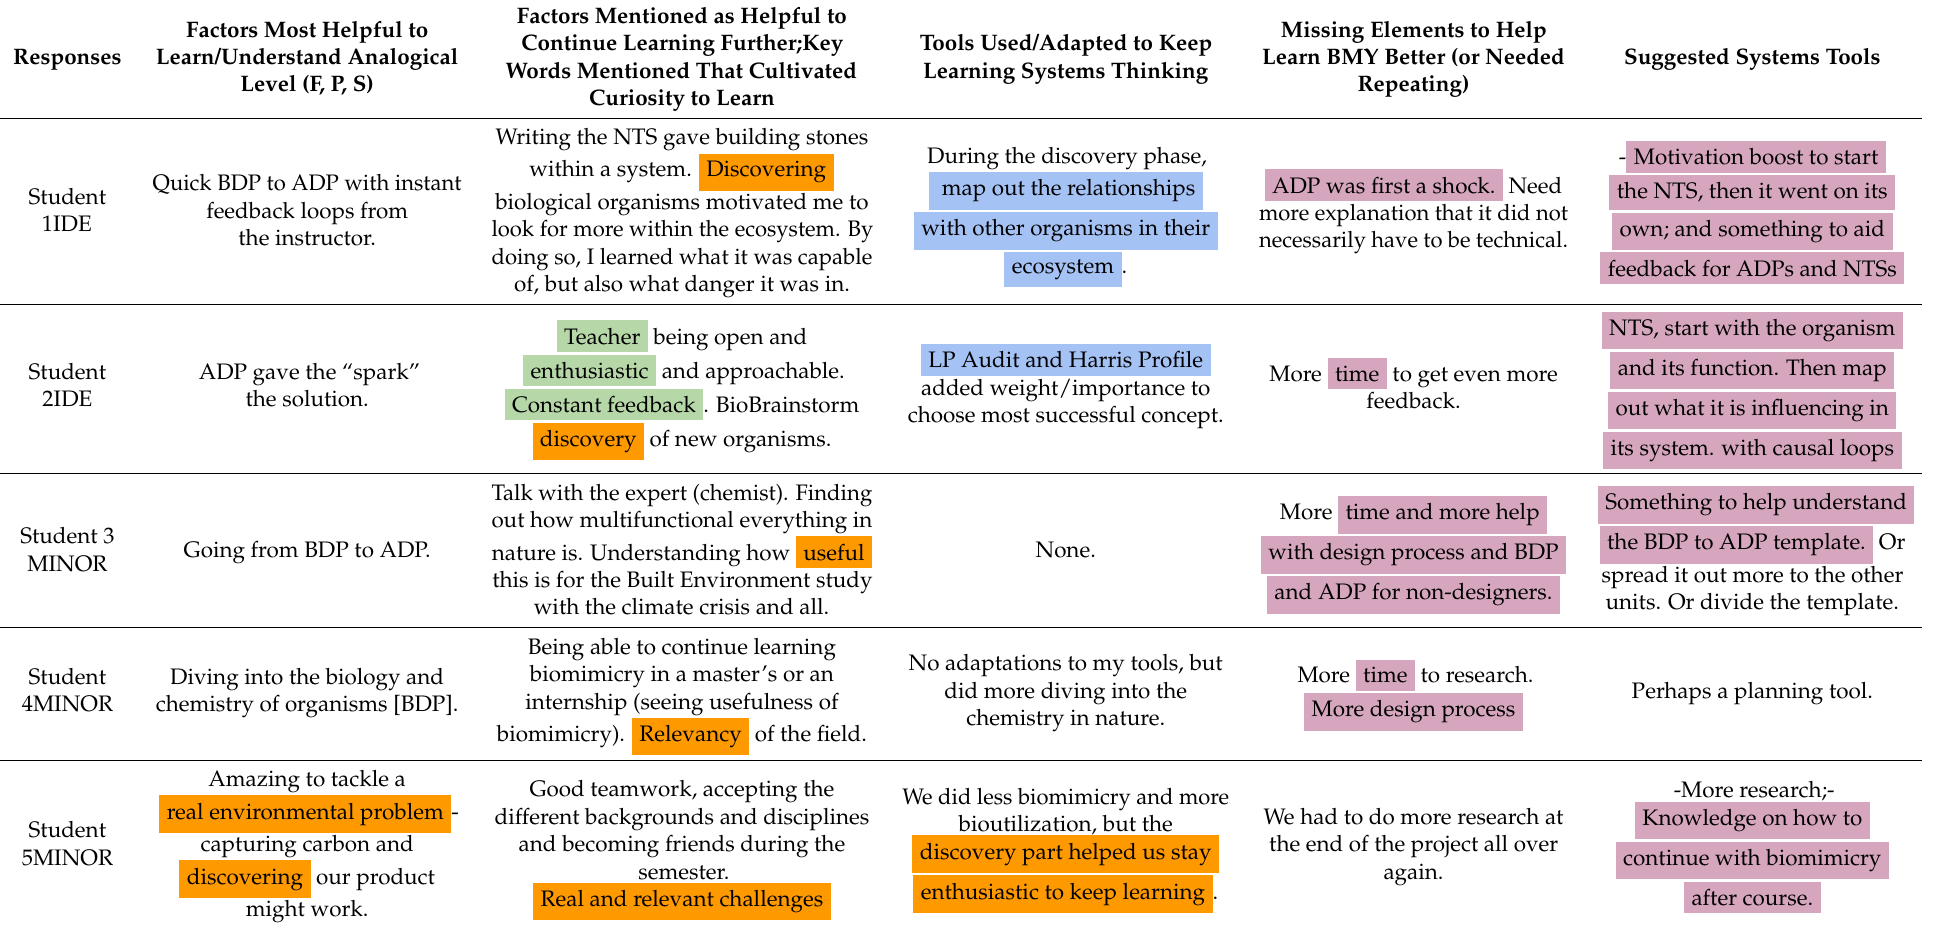
Table 2. Student cohort of 2022 interview and discussion responses—Acceptance, application and gaps of